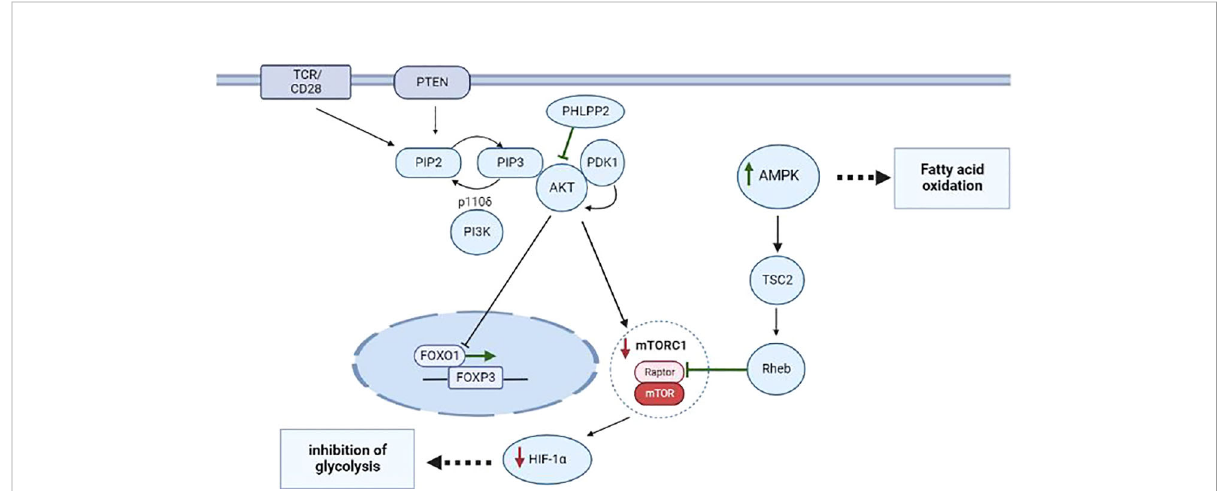
FIGURE 1 Metabolism of CD4 + T cells during proliferation and differentiation into Treg cells thymus and periphery. The most important role in the differentiation of CD4 + T cells into Treg cells belongs to the interaction of metabolic and transcription factors during stimulation of TCR and CD28 and activation of the PI3K – AKT – mTORC1 pathway. Additionally, during the negative selection, a phosphatase called PHLPP inhibits the expression of PI3K – AKT pathway components, thus preventing the translocation of FOXO1, thereby upregulating FOXP3 in nTreg cells. Via TSC2 and GAP-Rheb, AMPK activity leads to the inhibition of a protein complex known as mTORC1, to suppression of HIF-1 a , and to activation of processes responsible for FAO. Events that induce differentiation into Treg cells are highlighted in green; processes that are inhibited in Treg cells are marked in